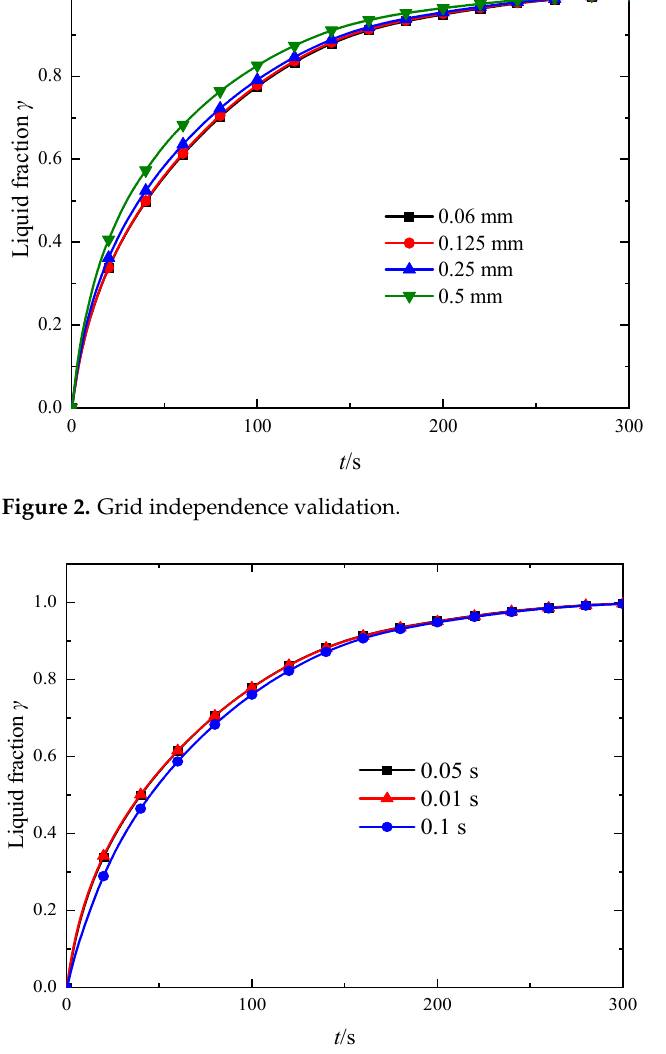
Figure 3. Time step independence validation.